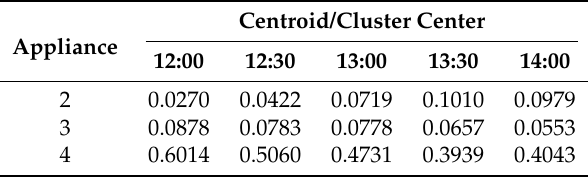
Figure 2. Bayesian prediction model: eight input evidence nodes. Table 7. Node probability table-appliance marginal distribution.